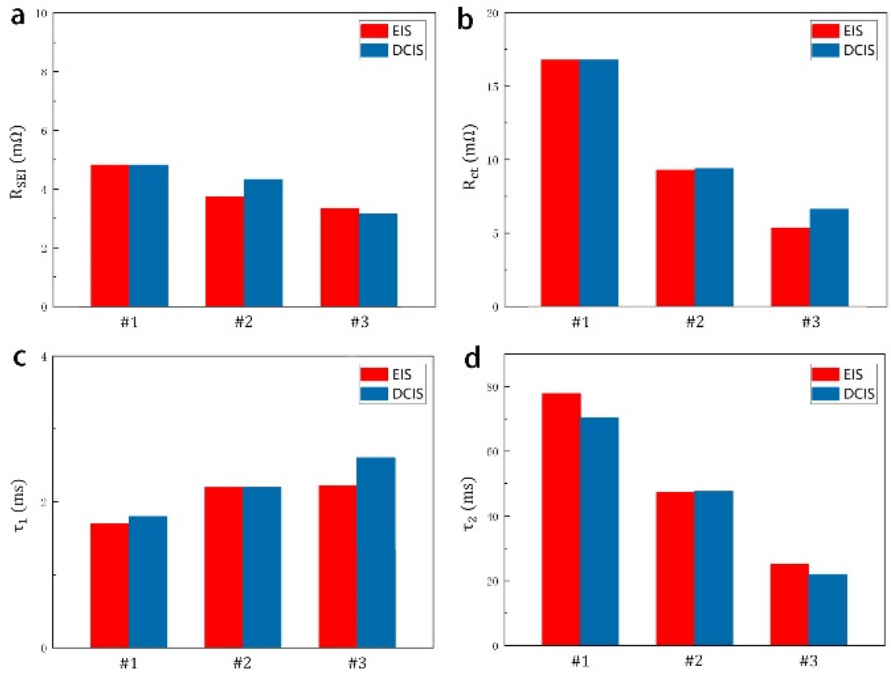
Figure 5. DCIS and EIS comparison histogram for ( a ) R SEI ; ( b ) R ct ; ( c ) High frequency RC network τ 1 ; ( d ) Low frequency RC network τ 2 .